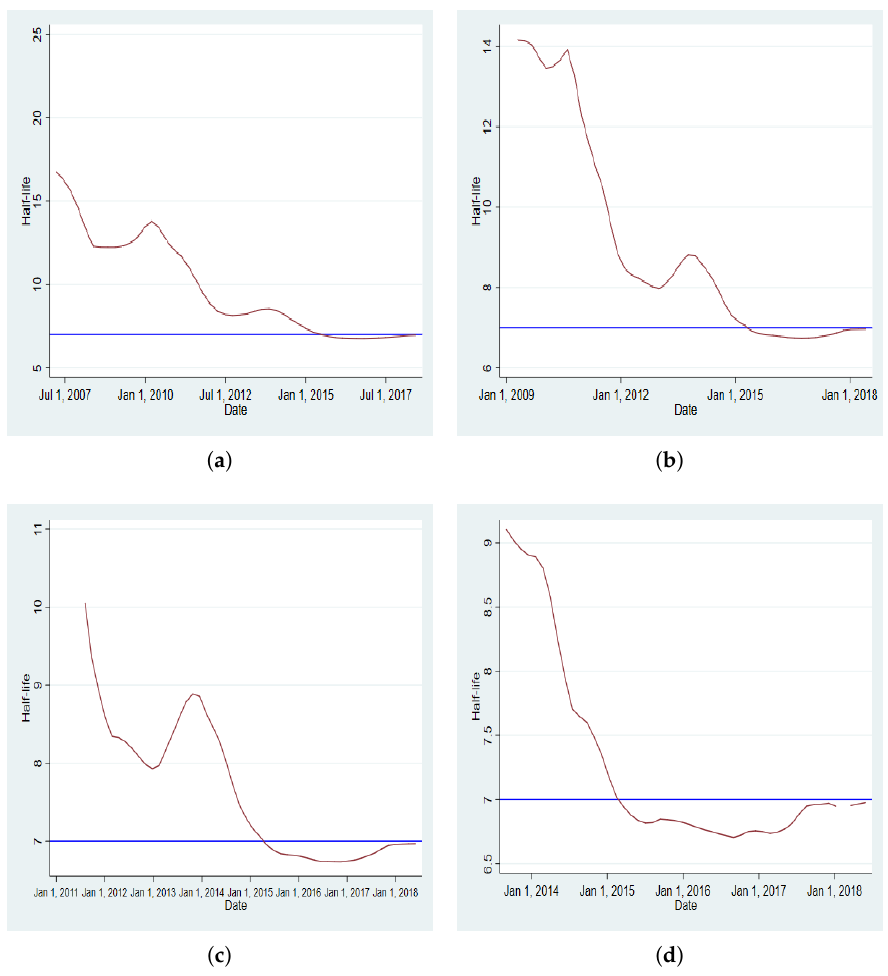
Figure A4. Dynamics of half-time for the BRVMC index using recursive rolling regression. These graphs plot the half-time estimated using rolling regression. The date is the end date for a selected window. In ( a ), the half-time is 14 days using recursive rolling regression with a window whose end date is 1 July 2007. ( a ) Dynamics of half-time for the BRVMC index using recursive rolling regression with a 2-year window; ( b ) Dynamics of half-time for the BRVMC index using recursive rolling regression with a 4-year window; ( c ) Dynamics of half-time for the BRVMC index using recursive rolling regression with a 6-year window; ( d ) Dynamics of half-time for the BRVMC index using recursive rolling regression with an 8-year